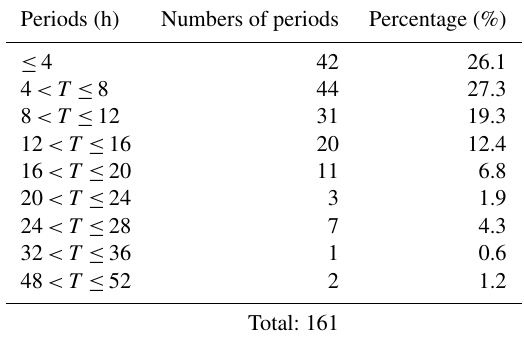
Table 1. Main periods of higher correlation between the IMF B z component and AE